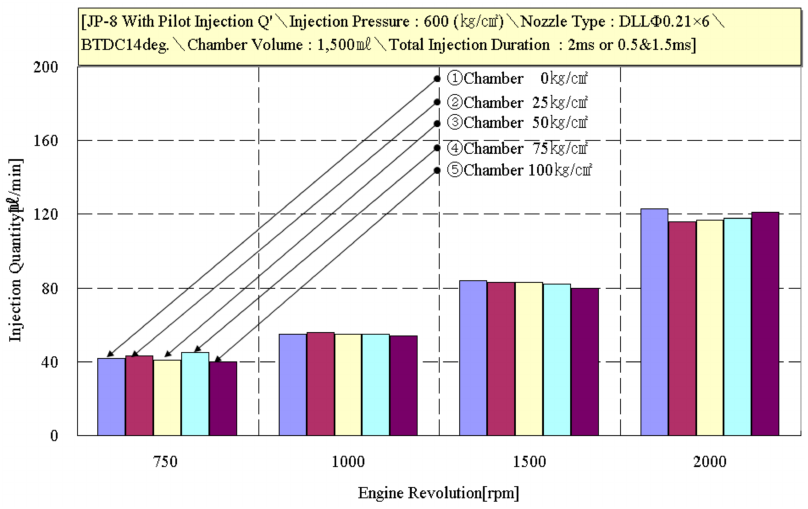
Figure 16. Injection Quantity on Engine Revolution with Pilot Injection of JP-8 Aviation